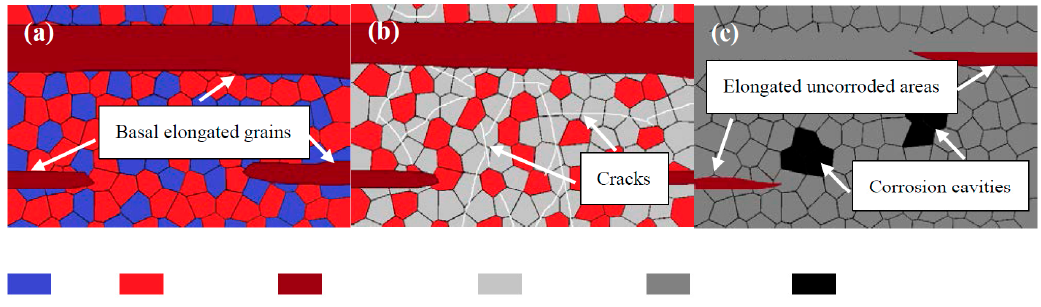
Figure 11. Schematic illustration of corrosion mechanism of the alloy in SBF solution ( a ) at initial time, ( b ) at middle time, ( c ) at final time.